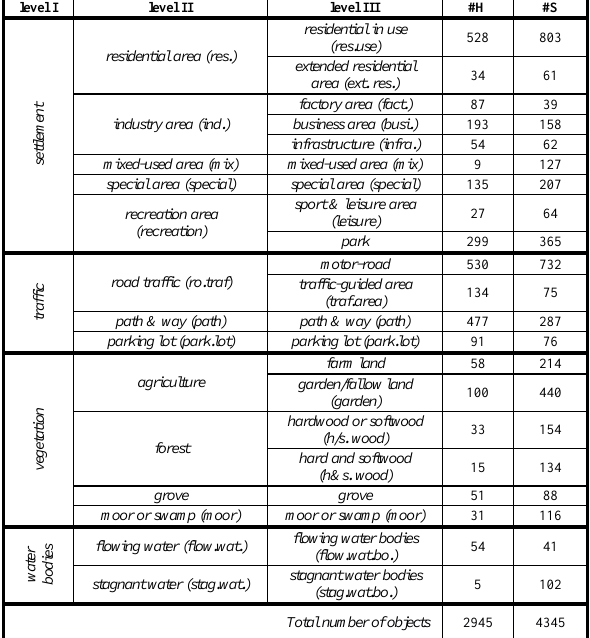
Table 1. Hierarchical class structure. Abbreviations are shown in brackets. #H / #S : number of samples in level III for Hameln and Schleswig, respectively.